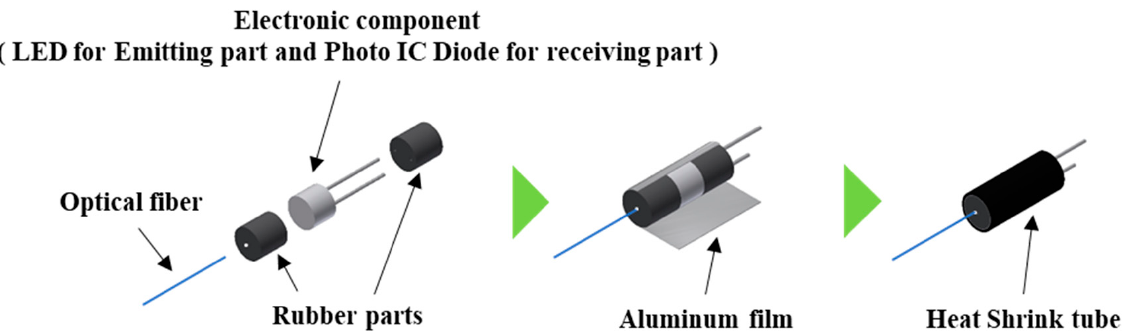
Figure 7. Structure of the emitting and receiving parts.